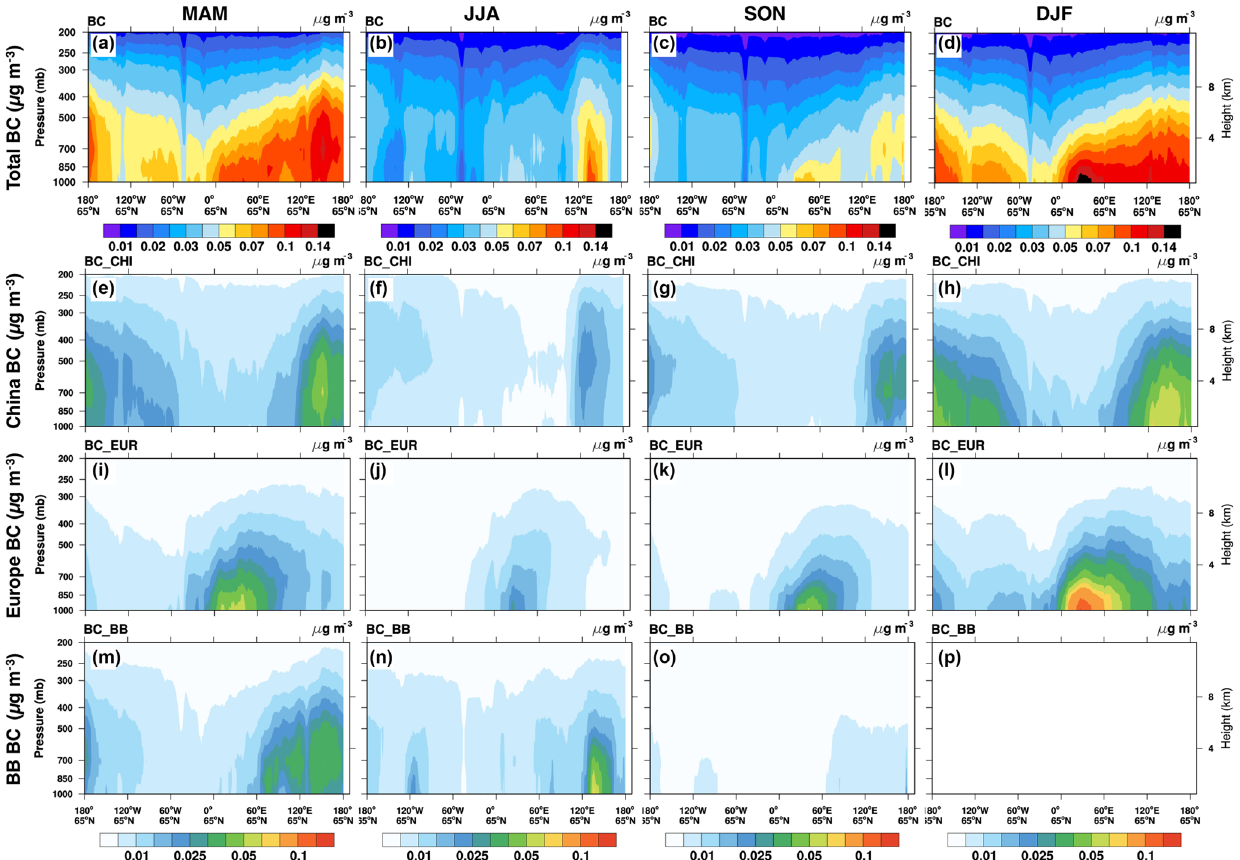
Figure 14. Cross-section at 65 ◦ N for different seasons. Panels (a–d) show the BC concentrations (in µgm − 3 ) at the 65 ◦ N cross-section. Panels (e–p) show the contributions of China, Europe, and biomass burning (BB) to BC at 65 ◦ N. JJA denotes the average for the months of June, July, and August. SON (p) denotes average for the months of September, October, and November. DJF denotes the average for the months of December, January, and February. This figure is generated using NCAR Command Language (NCL) version 6.3.0, open-source software free to the public, by UCAR/NCAR/CISL/TDD, http://dx.doi.org/10.5065/D6WD3XH5 (last access: 13 November